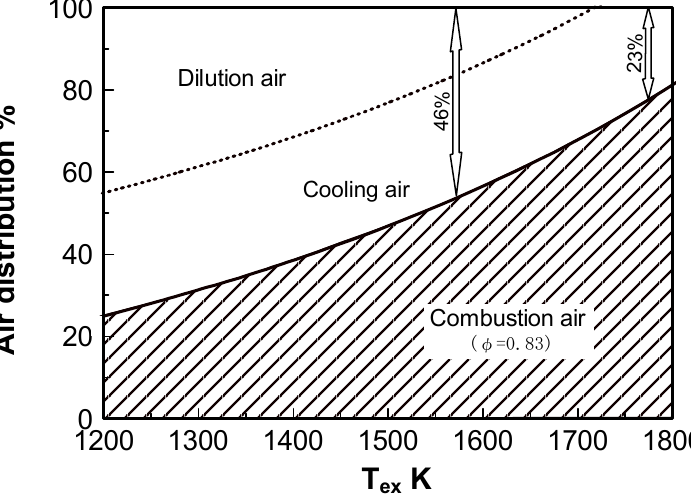
Figure 47. Air distribution design of gas turbine combustor that burns low-Btu gasified fuel.